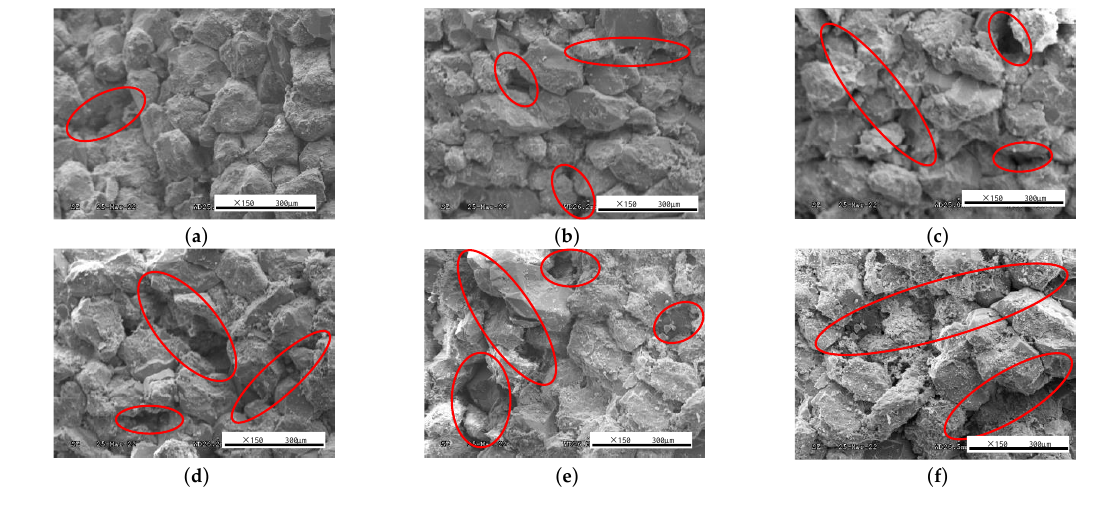
Figure 9. Microscopic morphology changes of rock samples with capillary freeze–thaw cycles: ( a ) 5 cycles; ( b ) 10 cycles; ( c ) 20 cycles; ( d ) 40 cycles; ( e ) 60 cycles; ( f ) 80 cycles.